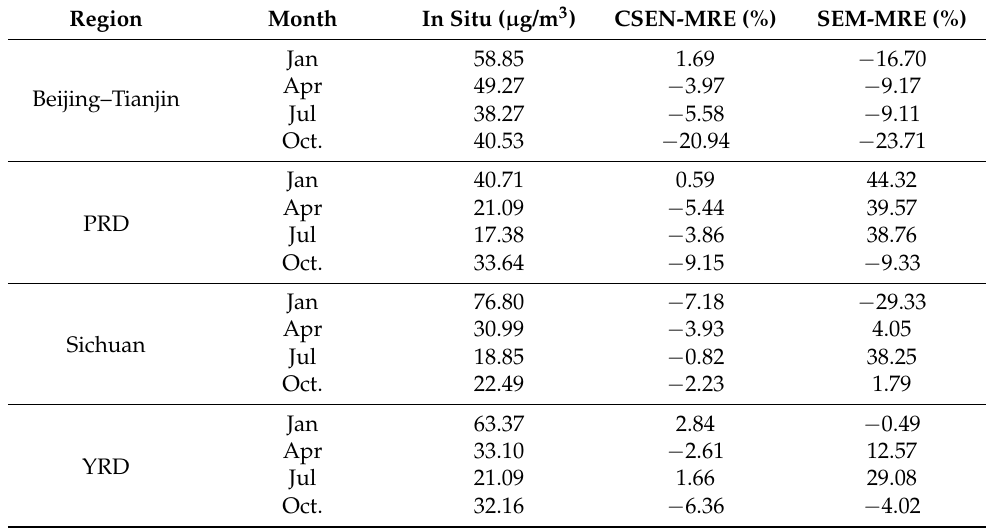
Table 2. Performance of the AOD–PM 2.5 algorithm with respect to the two methods in the four key urban